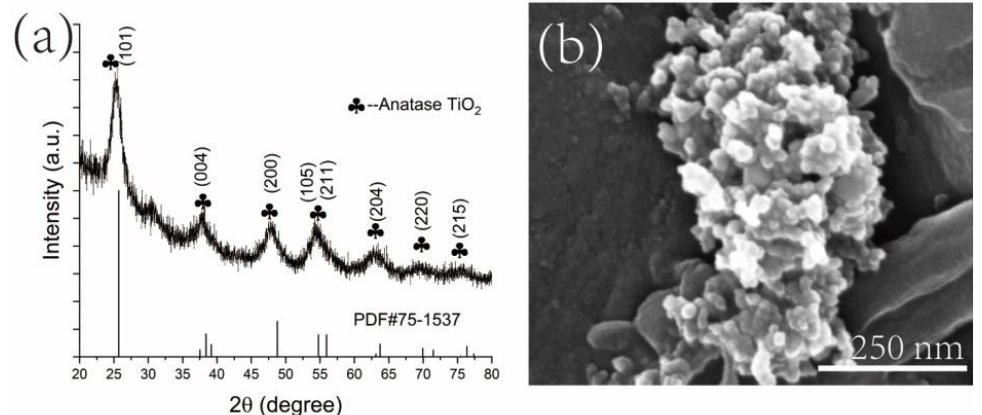
Figure 2. ( a ) XRD profile of the synthetic TiO 2 nanoparticles produced using a hydrothermal method at 190 °C for 2 h using urea and TiCl 3 ; ( b ) SEM image of the synthetic TiO 2 nanoparticles. The XRD patterns of the chitin, cellulose, TiO 2 , and TiO 2 /chitin/cellulose composites with cellulose/chitin ratios of 5/2, 5/1, and 10/1 are shown in Figure 3. The XRD pattern (a) of pulverized chitin particles has typical α -chitin crystal peaks at 2 θ = 9.39 ◦ , 12.67 ◦ , 19.72 ◦ , 20.73 ◦ , 23.33 ◦ , and 25.90 ◦ , corresponding to the (020), (021), (110), (120), (130), and (013) crystal indexes, respectively [45]. The curve (b) for the 3D-printed pure cellulose matrix has typical XRD profile peaks at 2 θ = 12.3 ◦ (101), 20.3 ◦ (10-1), and 21.6 ◦